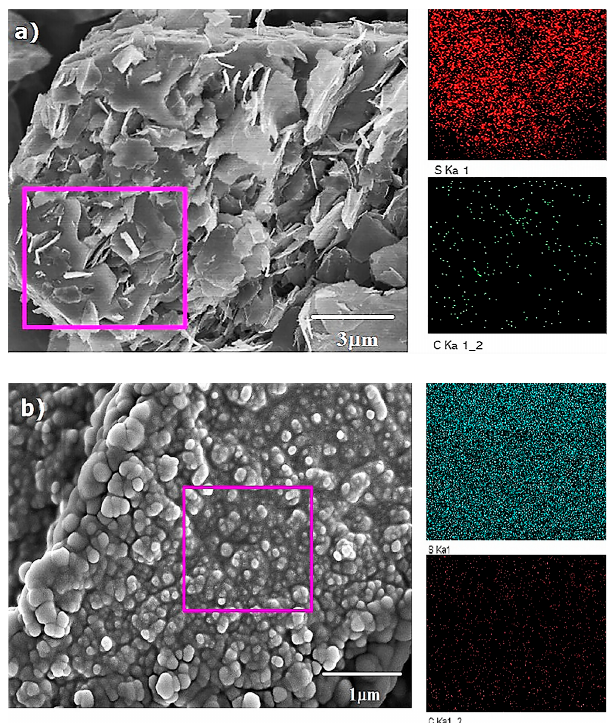
Figure 7. ( a ) SEM of poly(S-Sty-P) terpolymer @ GF; ( b ) SEM of poly(S-Sty-P) terpolymer @ CCB.